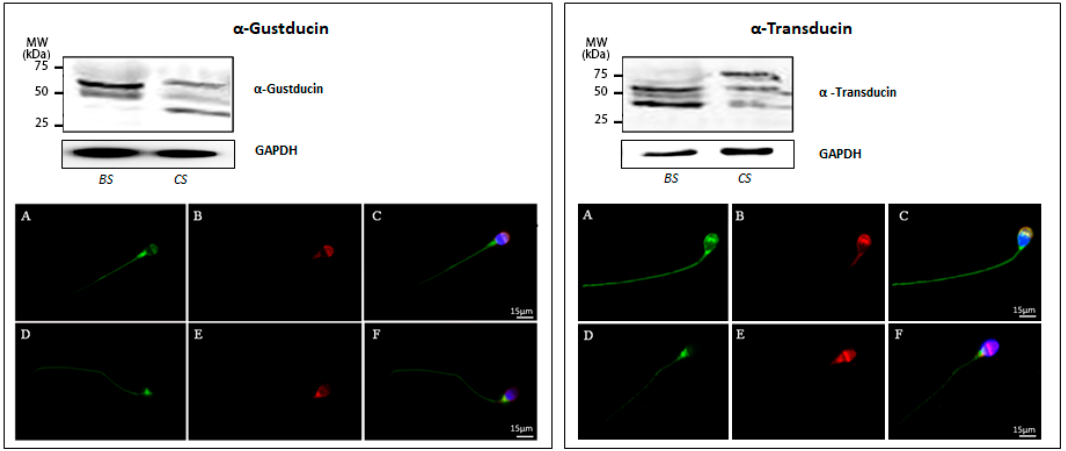
Figure 6. Expression of α -gustducin (left panel) and α -transducin (right panel) in human ejaculated sperm. ( Top ) Western blot of α -gustducin and α -transducin in ejaculated sperm before (BS) and after in vitro capacitation (CS). GAPDH was immunodetected to control equal loading per lane for the two examined sperm suspensions. ( Bottom ) Representative images of immunofluorescence staining (from three independent experiments) of α -gustducin and α -transducin (green), PSA (red), and DAPI (blue) in ejaculated sperm before ( A – C ) and after in vitro capacitation ( D – F ). Scale bar = 15 μ m.